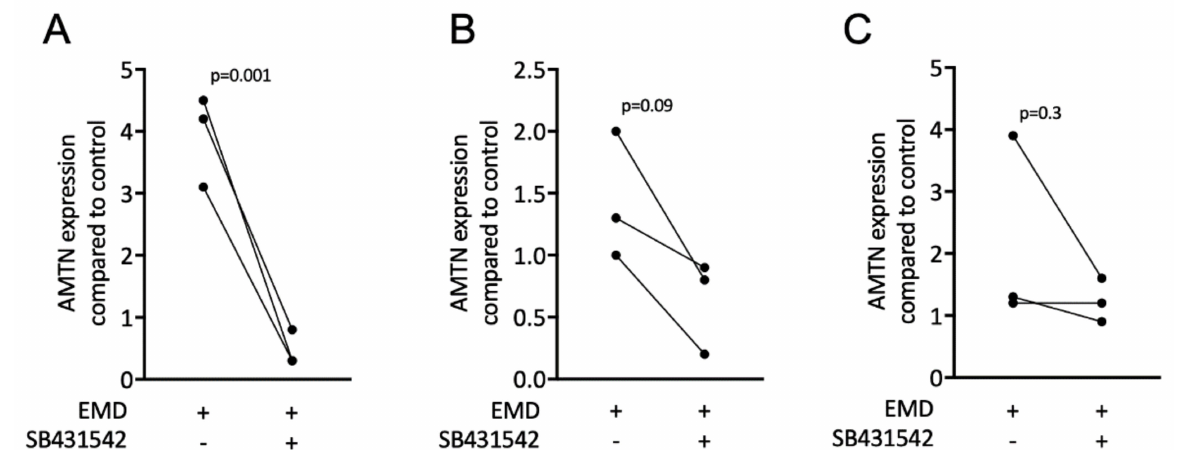
Figure 4. EMD increases the expression of AMTN, dependent on SB431542. RT-PCR of AMTN showed increased expression by EMD, which was blocked by SB431542 in ( A ) HSC2. An increase of AMTN was not observed in ( B ) TR146 or ( C ) GF. Statistics based on two-tailed Mann–Whitney test.